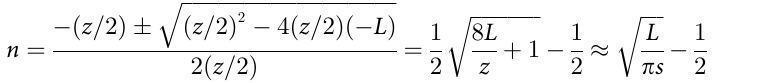
ffiffiffiffiffiffiffiffiffiffiffiffiffiffi 8 L